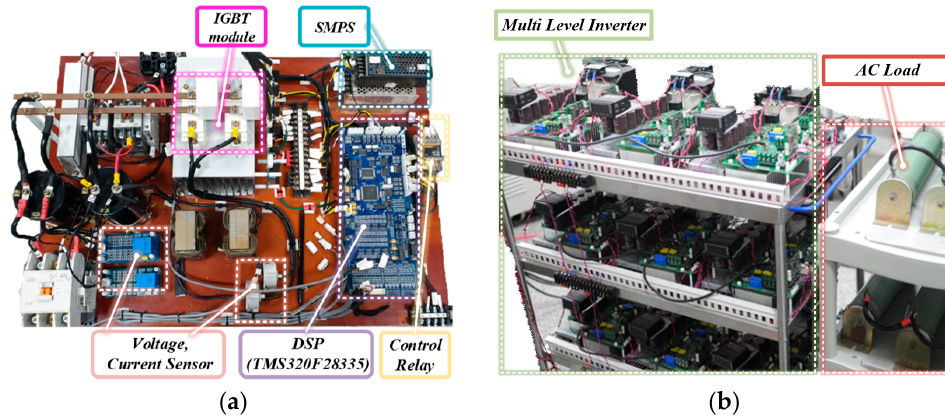
Figure 10. Experiment configuration of power conversion devices ( a ) PV converter, ( b ) MLI.